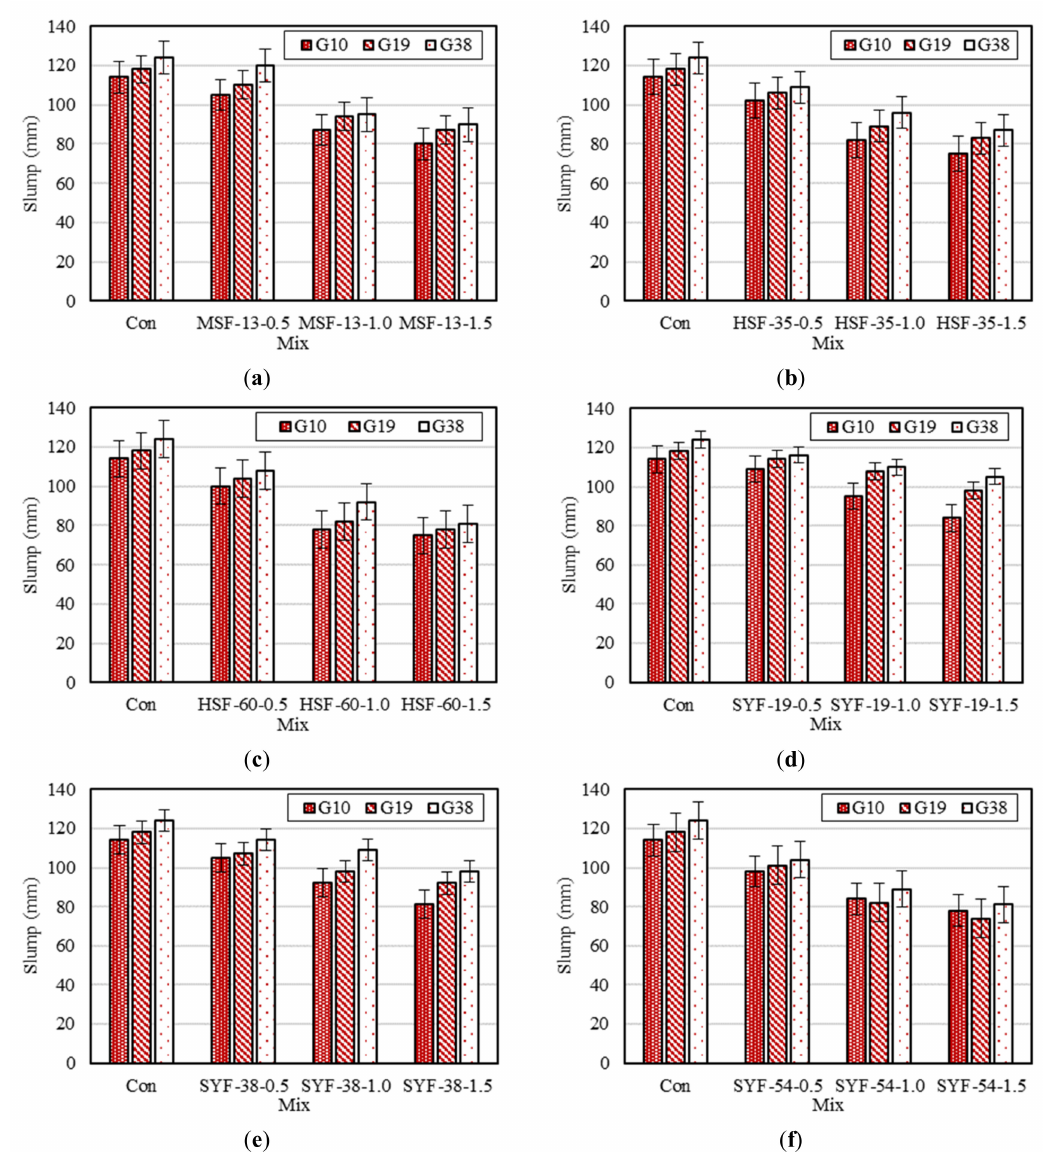
Figure 3. Effects of fiber type, dosage, and coarse aggregate maximum size (CAMZ) on the slump for the ( a ) MSF-13, ( b ) HSF-35, ( c ) HSF-60, ( d ) SYF-19, ( e ) SYF-38, and ( f ) SYF-54